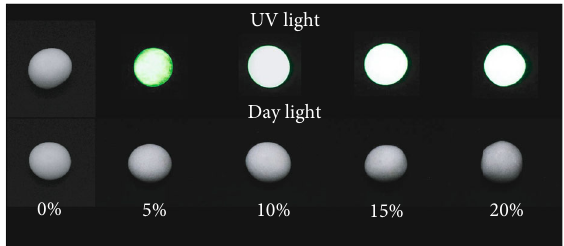
Figure 6: Phosphor-in-glass ceramic aggregates with varying phosphor contents with UV light exposure and in daylight.